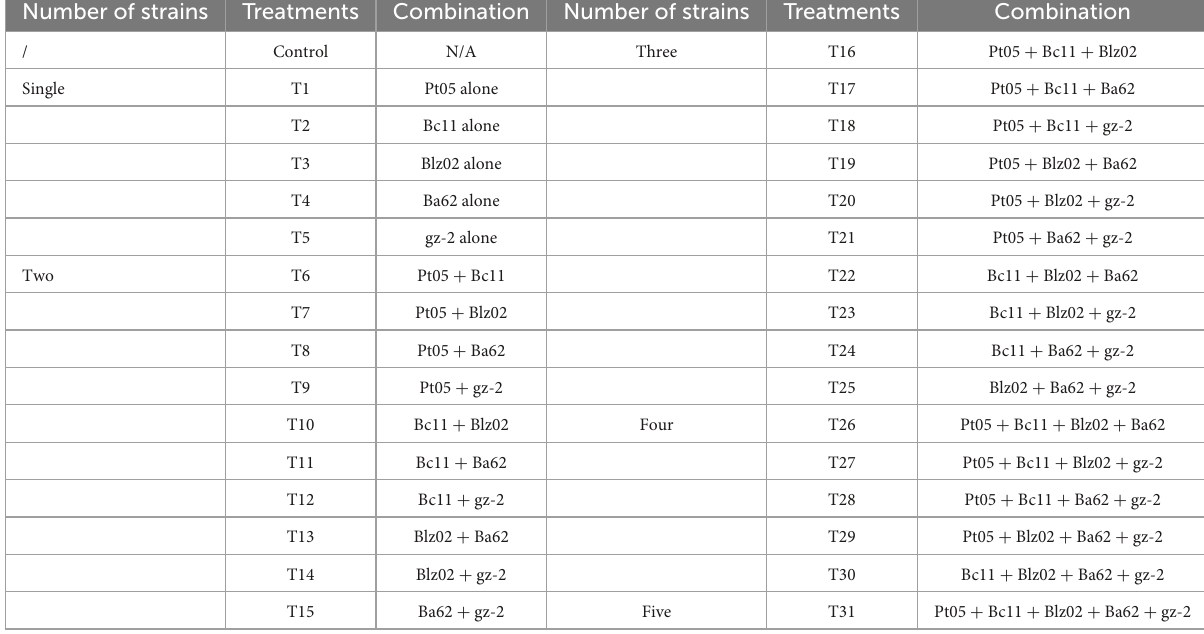
TABLE 1 Biocontrol strains and their combinations used to determine their biocontrol efficacy on Fusarium wilt of banana. Number of strains Treatments